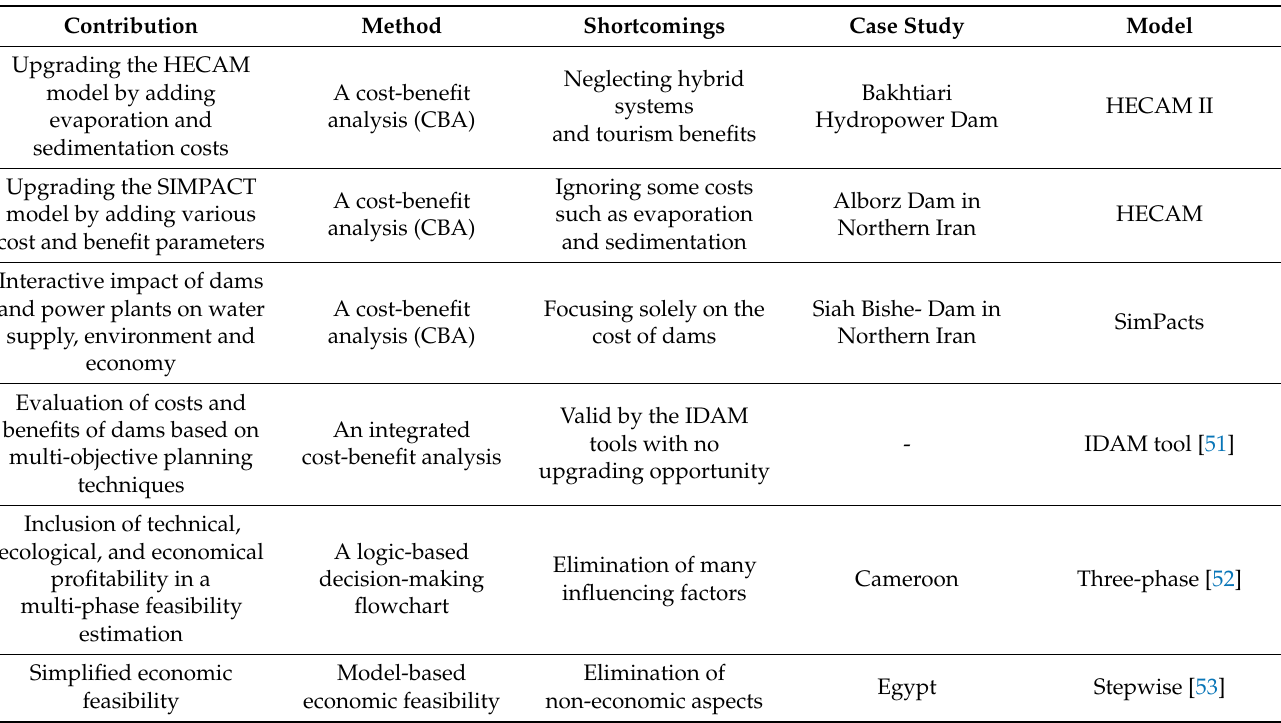
Table 5. A comparison between similar feasibility